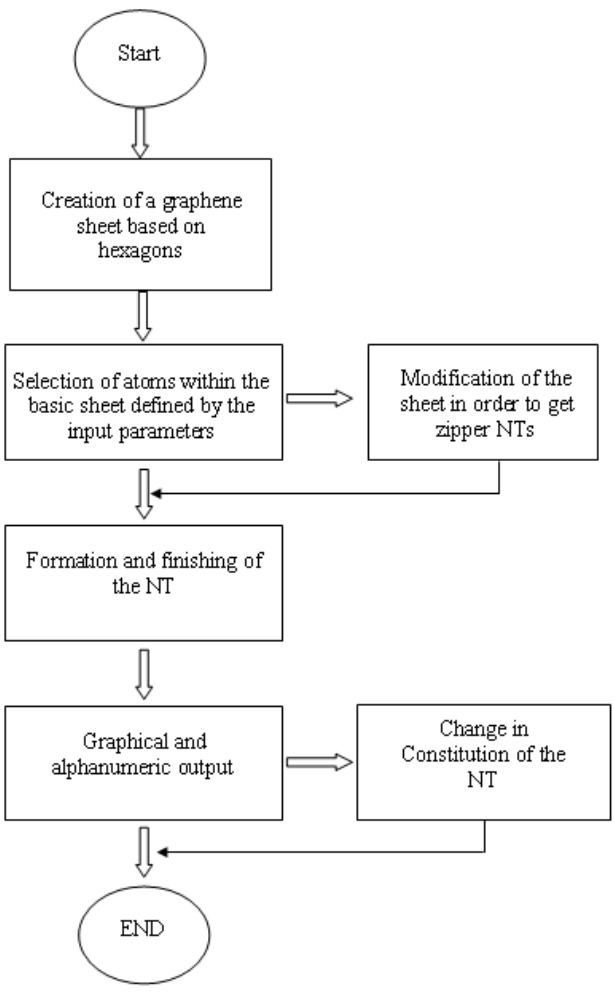
Figure 1. General flow diagram of the MCAD system for generation of nanotubes, starting from a graphene